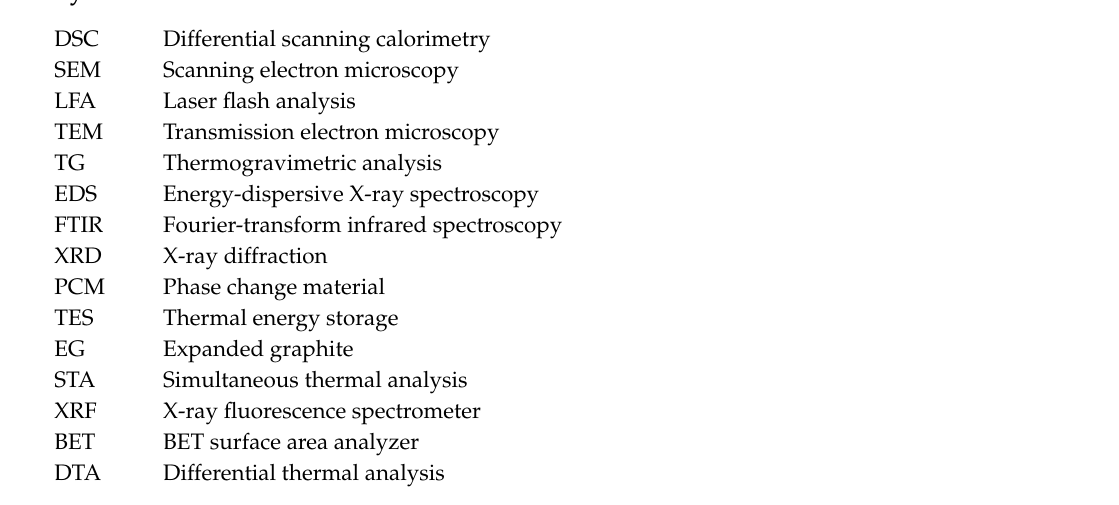
Figure 10. XRD Patterns of composite PCM (S8) heated over 950 °C.